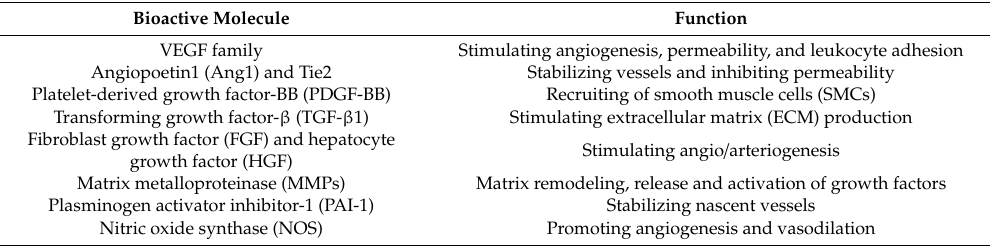
Table 1. Some of the major angiogenic bioactive molecules that play critical roles in angiogenesis (sorted by time of occurrence) [14]. VEGF, vascular endothelial growth factor.